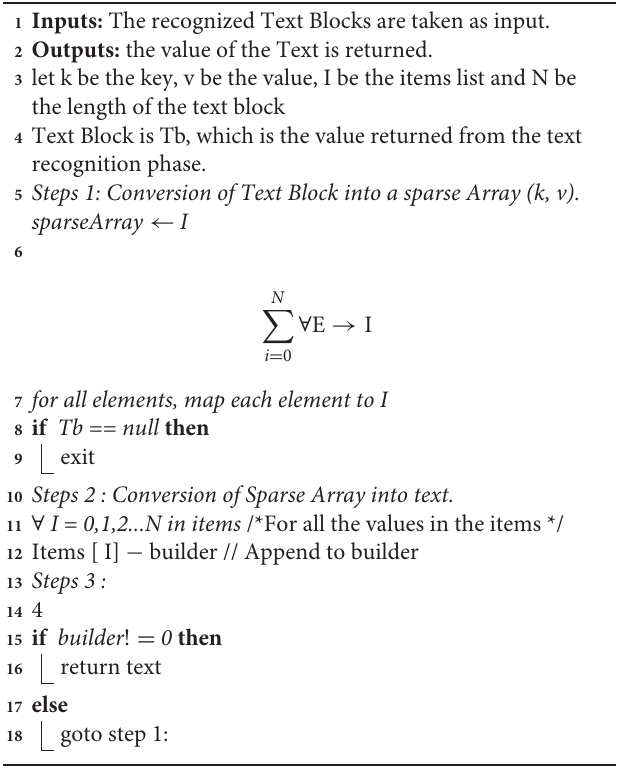
Algorithm 3: Post